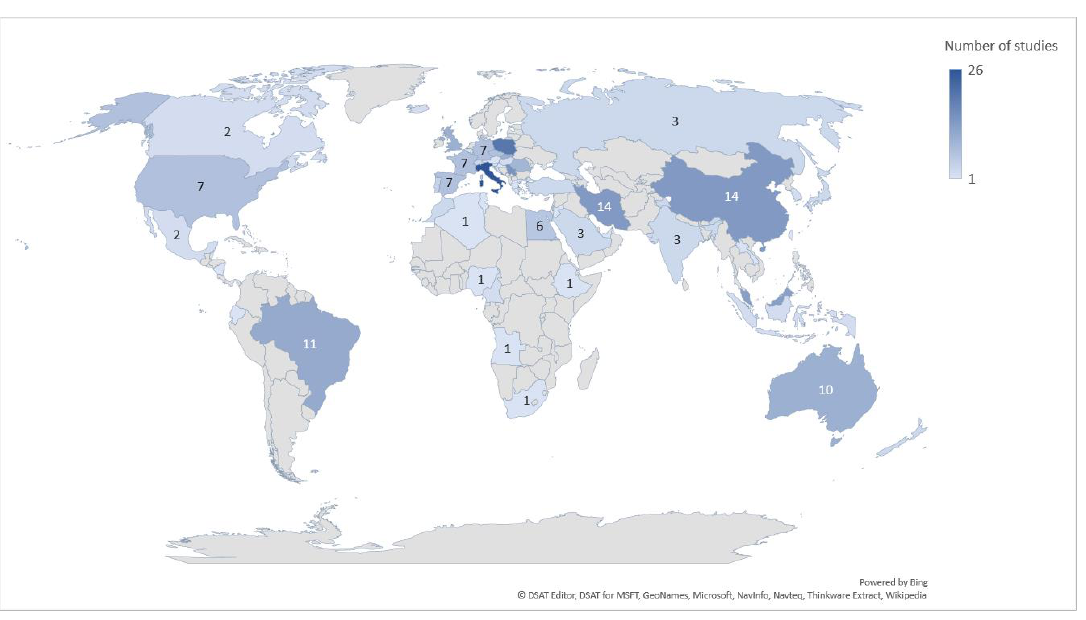
Figure 3. Geographical distribution of research studies on geotourism.